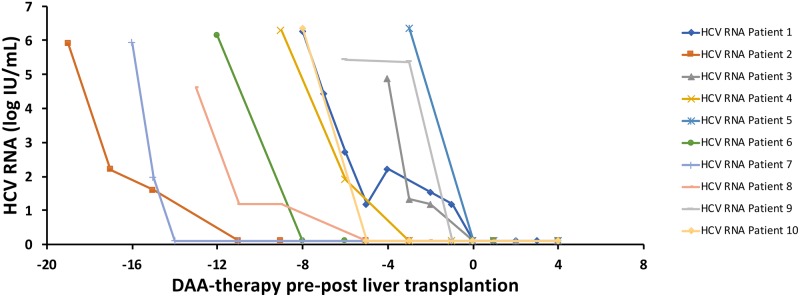
HCV-RNA levels pre- and post-LT.The individual HCV RNA levels at start of DAA-therapy, at the day of liver transplantation as well as up to 4 weeks post-transplant, i.e., the study period.